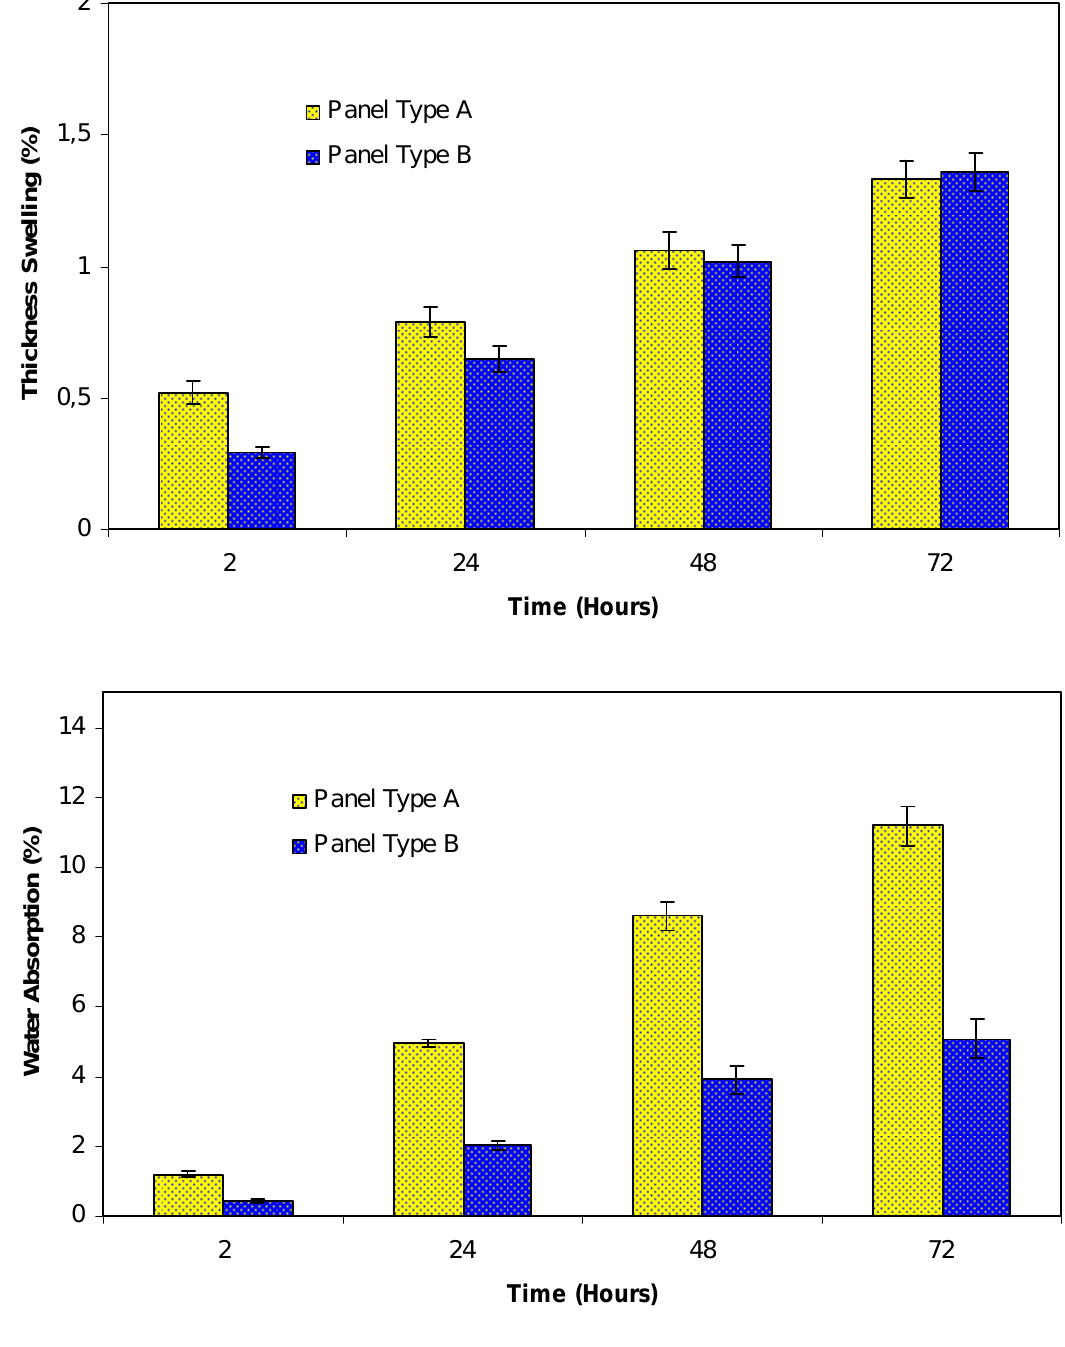
Figure 1. Thickness swelling values and water absorption values of unmodified (A) and MAPE modified (B) HDPE based wood plastic